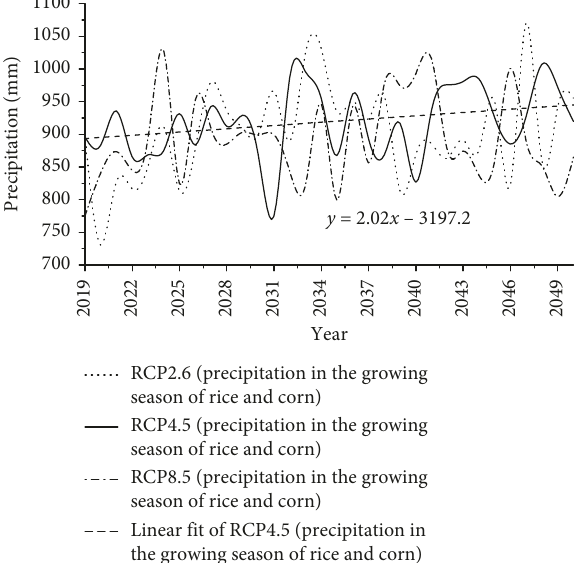
y = 2.02 x – 3197.2